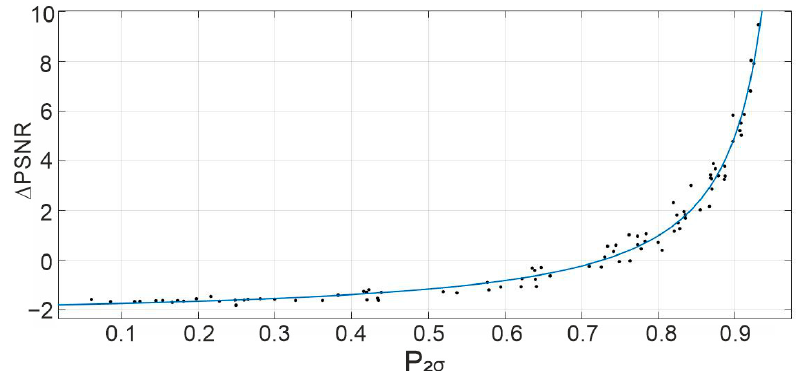
∆ PSNR vs. P 2 σ and the fitted curve.